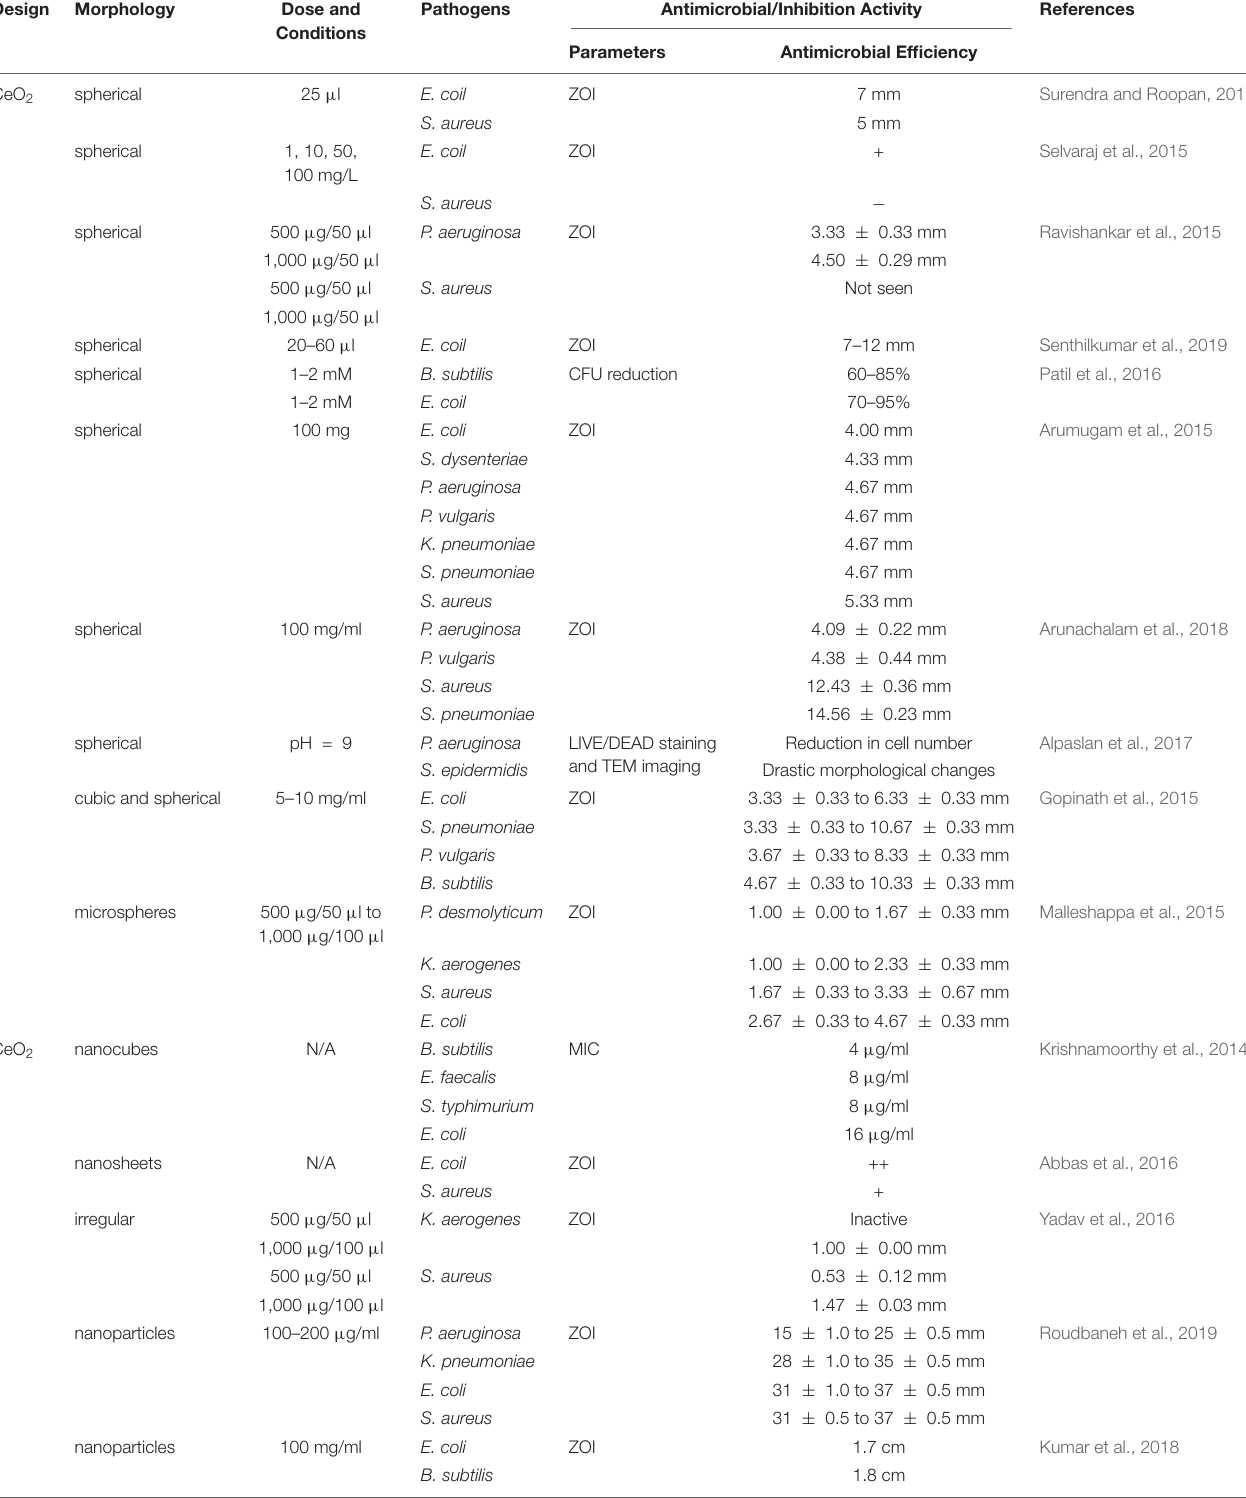
TABLE 1 | Recent studies on cerium dioxide against various